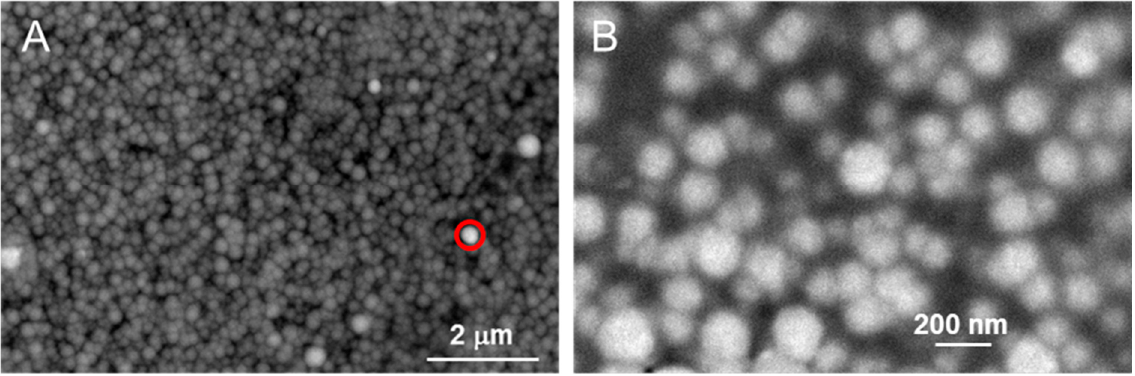
Figure A4. Scanning electron microscopy (SEM) characterization of AV-TeNPs at low ( A ) and high ( B ) magnifications. The red circle in ( A ) indicates the location of a spot for EDX analysis (see text for details).